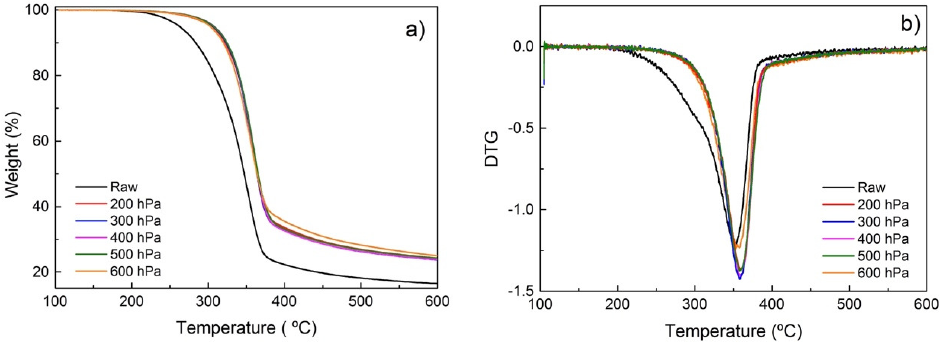
Figure 5. ( a ) TGA and ( b ) DTG for poplar treated at reduced pressures.